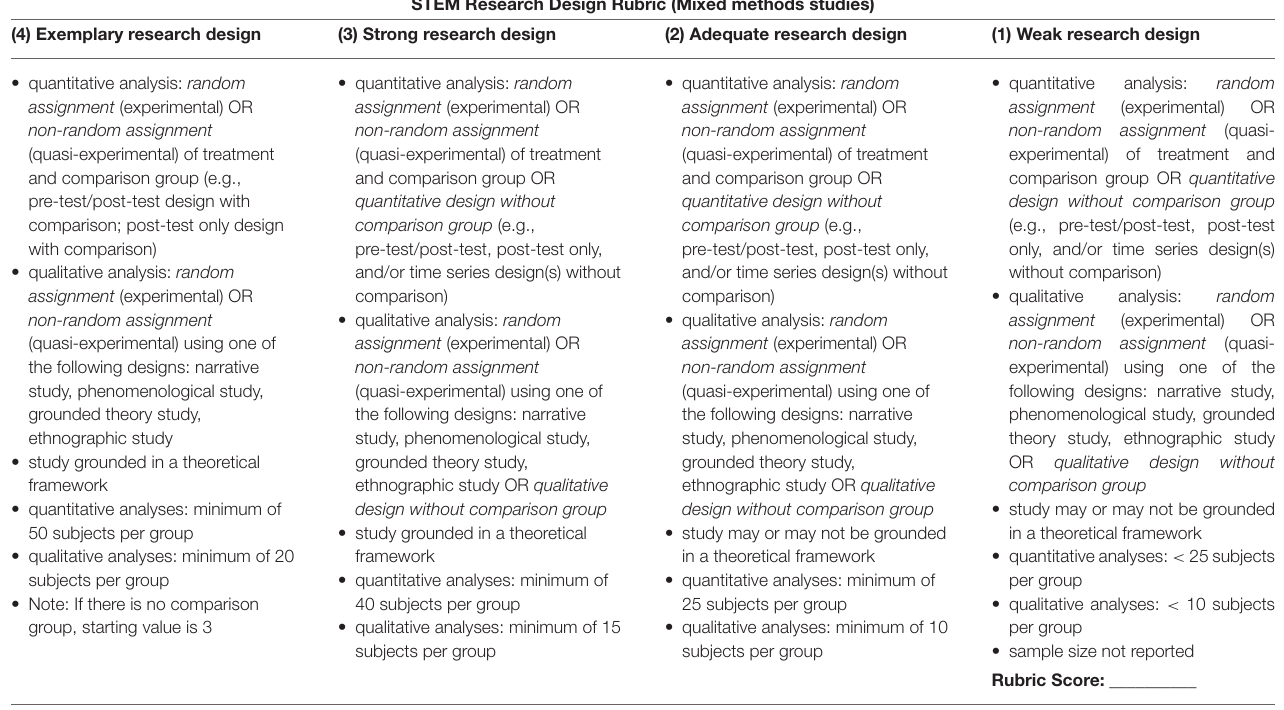
TABLE 6 | STEM research design rubric for mixed methods